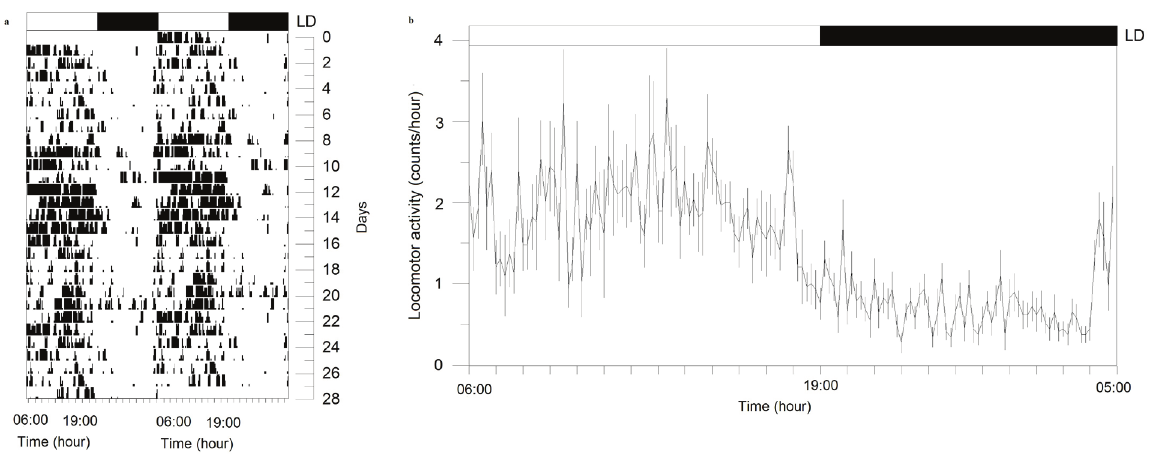
Figure 2 - Actogram ( a ) and average daily waveforms ( b ) for pirarucu’s ( Arapaima gigas ) locomotor rhythm measured by infrared photocells. The white and black bars at the top of the graphic indicate the duration of the light (13 h) and night (11 h) phases,